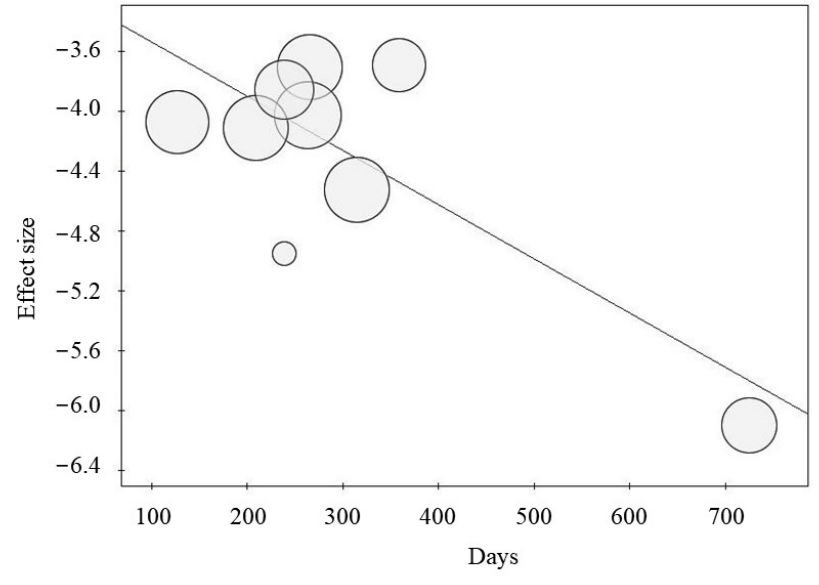
Figure 3. Meta-regression between dialysis vintage (days before RKF) and percentage of recovery of kidney function ( p = 0.007).